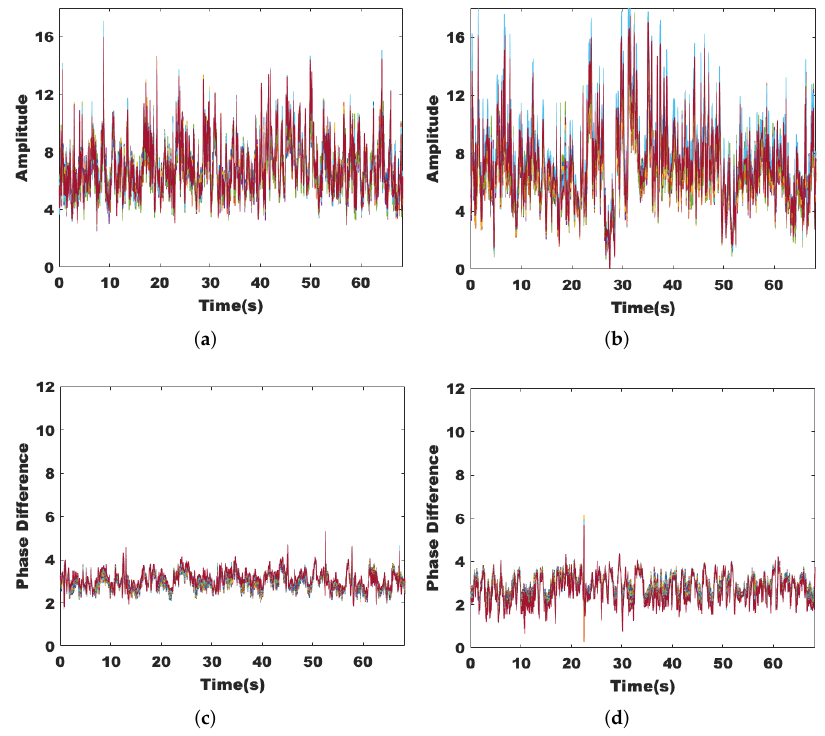
Figure 4. Robustness of amplitude and phase difference. ( a ) The amplitude under nLoS. ( b ) The amplitude under LoS. ( c ) The phase difference under nLoS. ( d ) The phase difference under